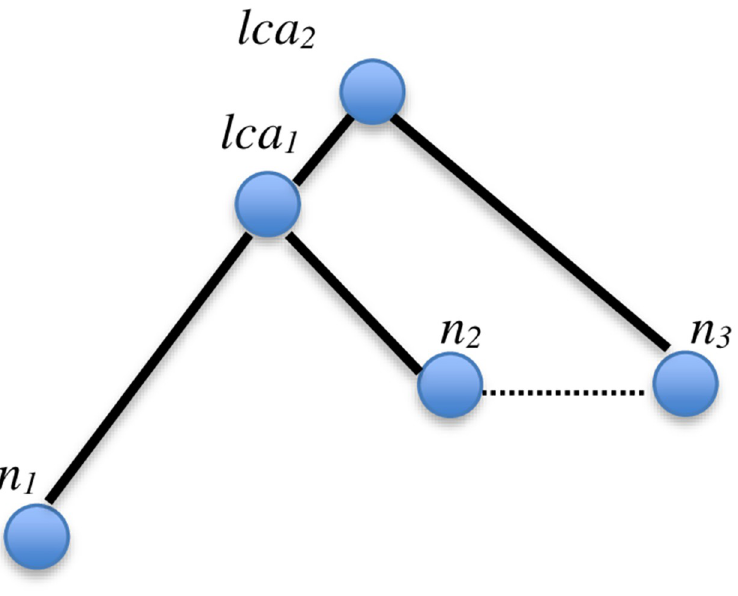
Fig 11. Since the subtree conforms to the RLCA concept, we can deduce an implicit Association Edge connecting nodes n 3 and n 1 , if nodes n 2 and n 3 are connected by an edge in the